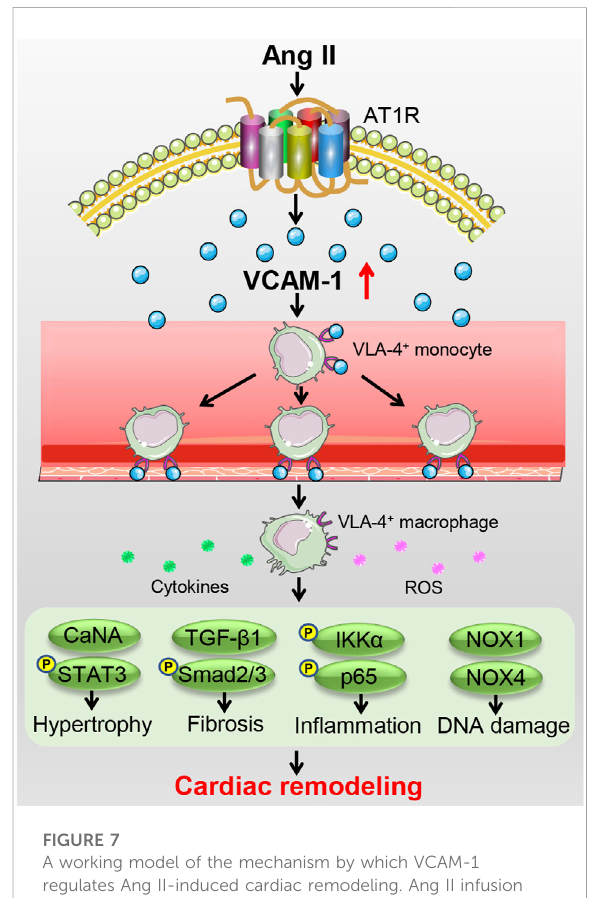
FIGURE 7 A working model of the mechanism by which VCAM-1 regulates Ang II-induced cardiac remodeling. Ang II infusion upregulates VCAM-1 expression, which promotes VLA-4 + macrophage adhesion to the endothelium and in fi ltration into the heart, inducing the release of abundant proin fl ammatory cytokinesandROStoactivatemultiplesignalingpathways,thereby leading to cardiomyocyte hypertrophy, myo fi broblast activation, and subsequent cardiac remodeling. Conversely, selective blockade of VCAM-1 effectively prevents these